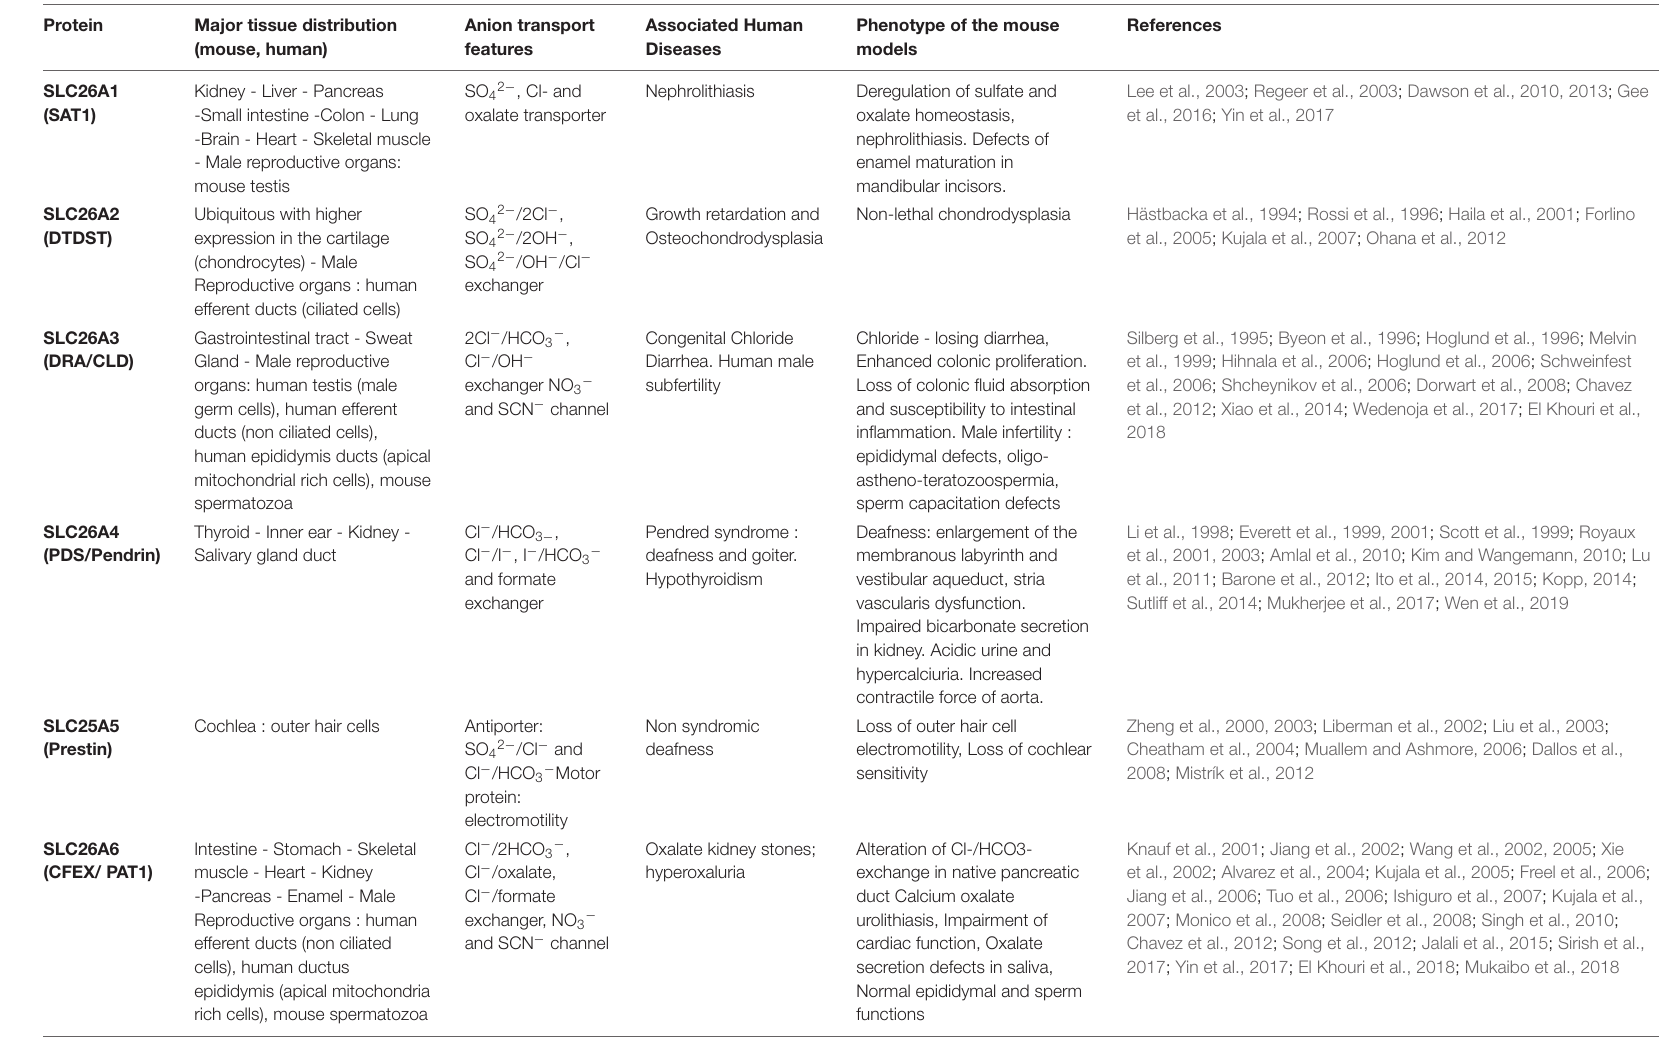
TABLE 1 | Principal features of SLC26 family members.